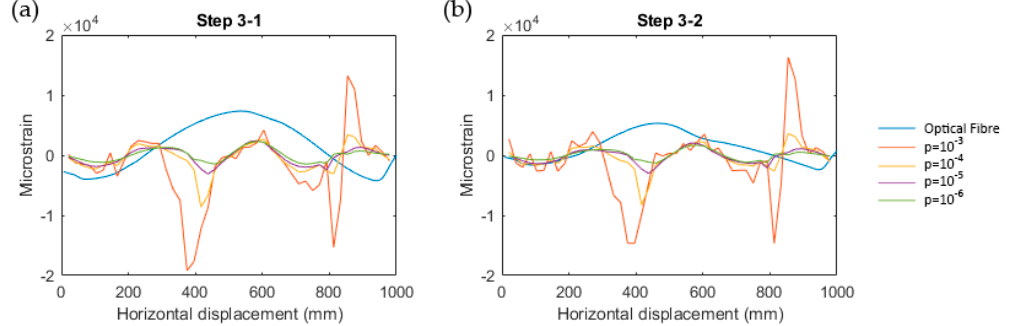
Figure 19. In-plane deformation test: Change in strain of Step 3 relative to the preceding strain; ( a ) Step 1 and ( b ) Step 2, at 180 mm of optical fibre and different cubic smoothing spline weighting parameter from 10 (cid:2879)(cid:2871) to 10 (cid:2879)(cid:2874) .